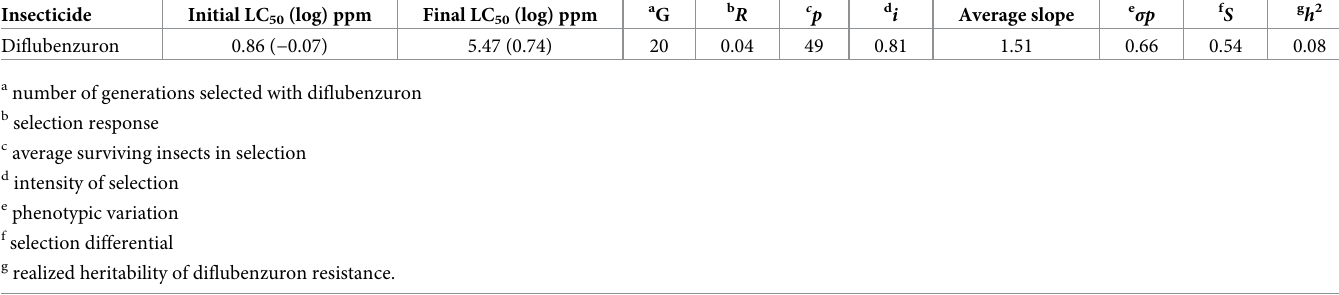
Table 4. Realized heritability ( h 2 ) for diflubenzuron resistance in the Diflu-SEL strain of M . domestica .